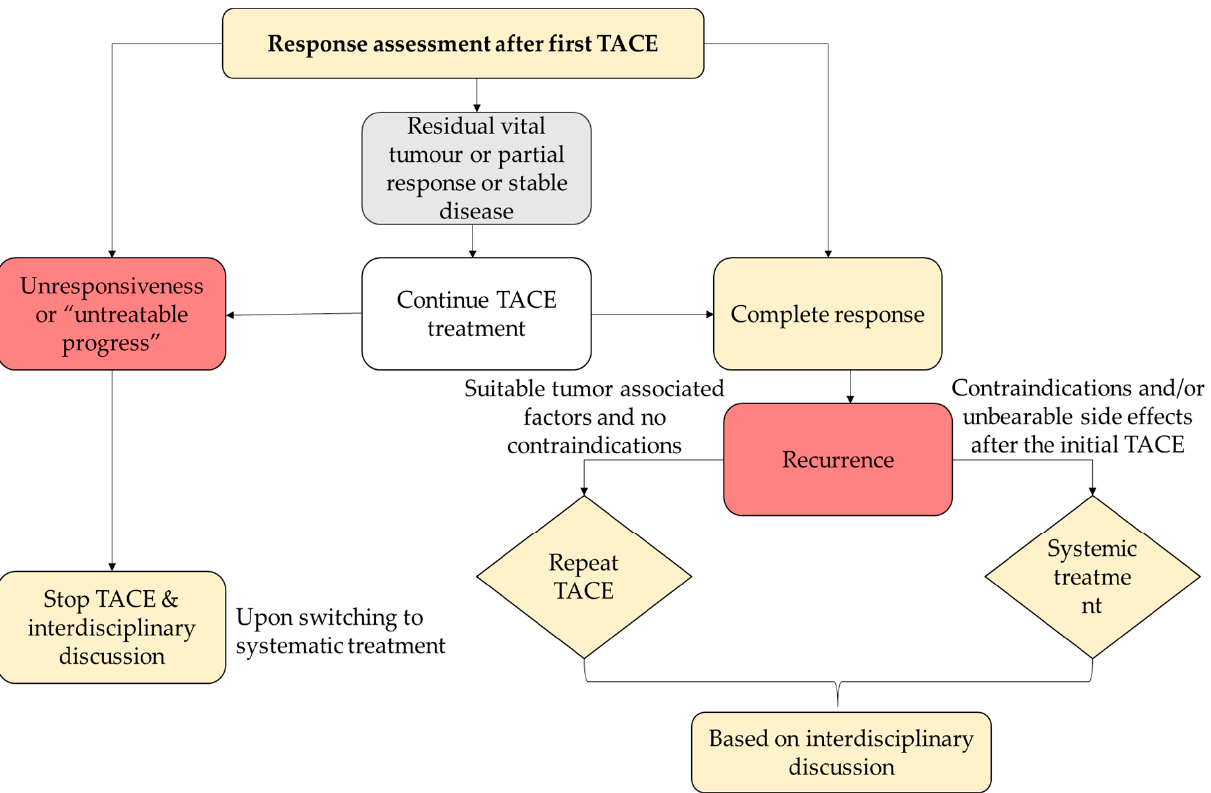
Figure 4. Re-evaluation criteria and decision-making during TACE. Figure adapted from Müller L et al., JHC2021 [84]. TACE: transarterial chemoembolization.